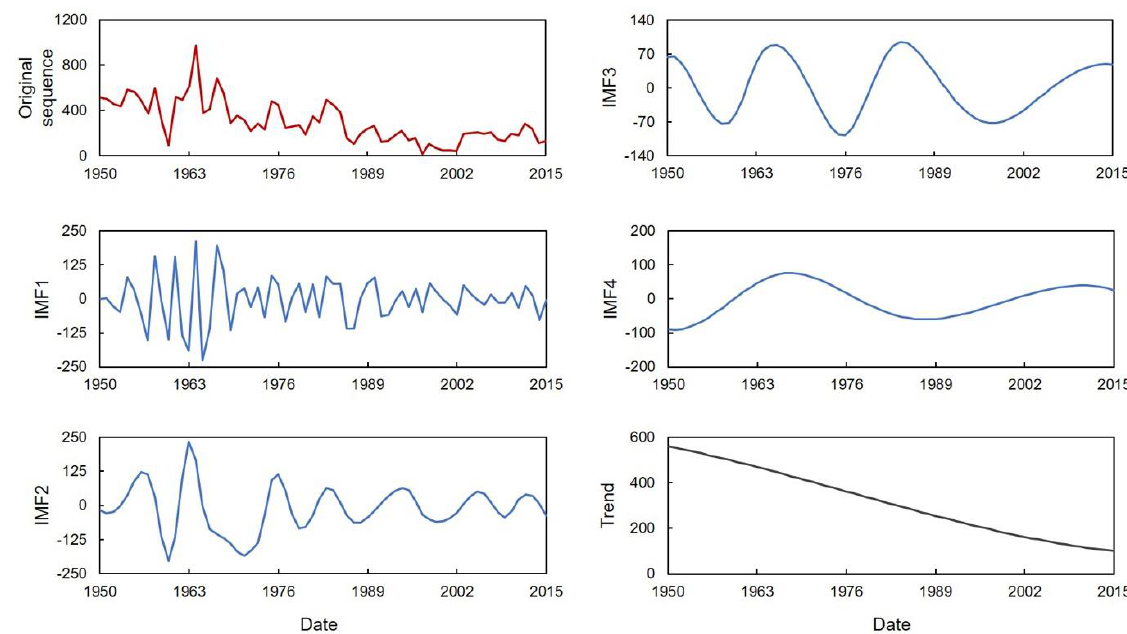
Figure 12. Empirical mode decomposition for the 66 a series of LHS.